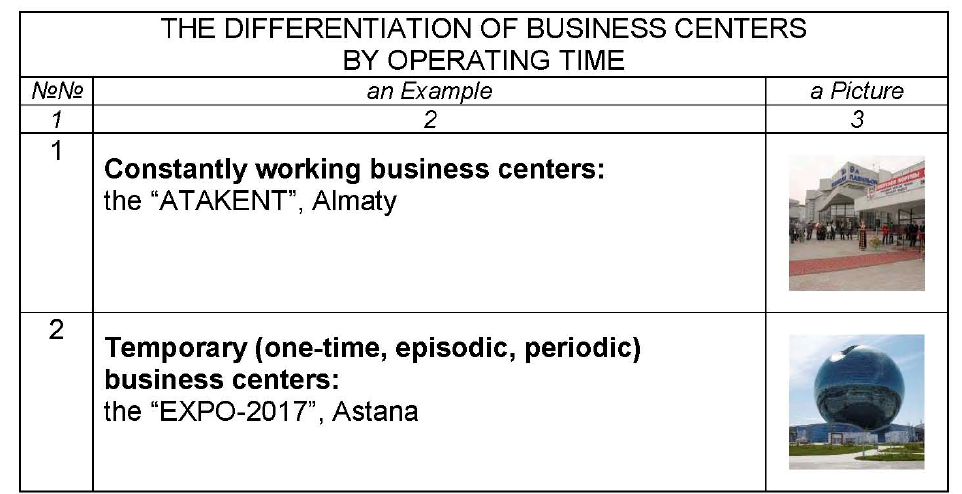
Figure 17. The differentiation of business centers by operating time: ( 1 ) the ATAKENT, Almaty [134]; and ( 2 ) the EXPO-2017, Astana [135].